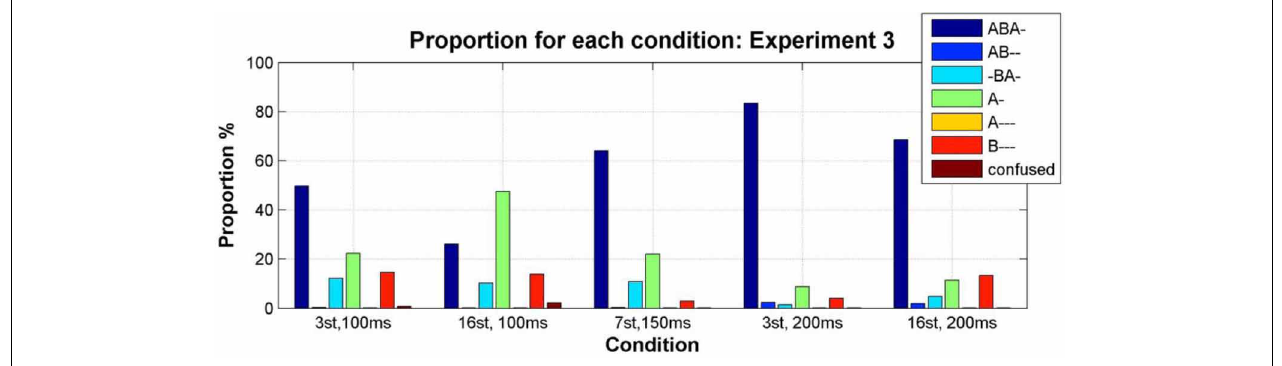
FIGURE 11 | Proportion of the total stimulus duration during which each pattern was perceived (color coded as indicated by the accompanying legend) for each condition, calculated